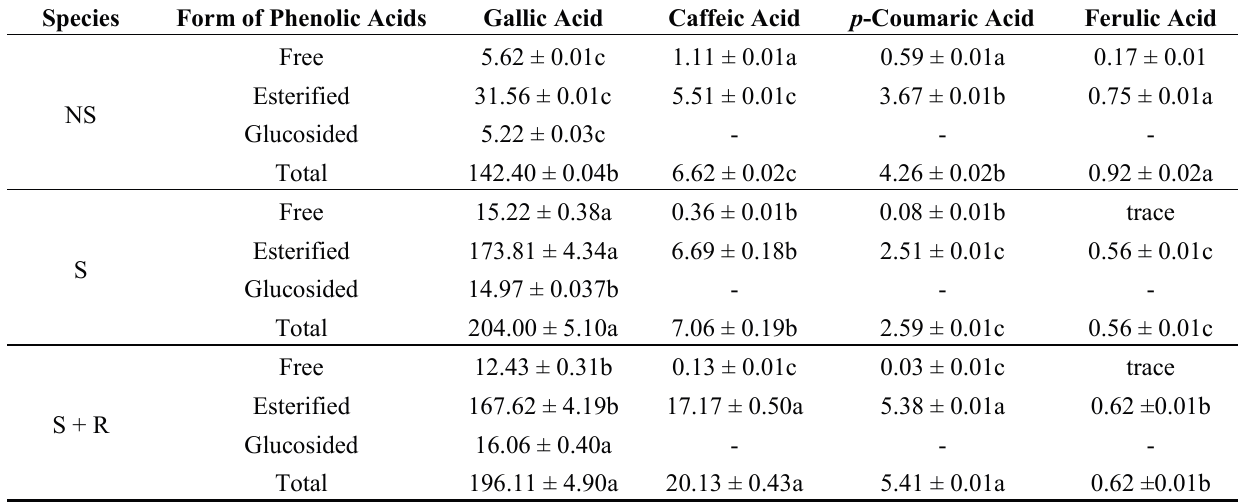
Table 3. Content of phenolic acid in seeds ( μ g/g